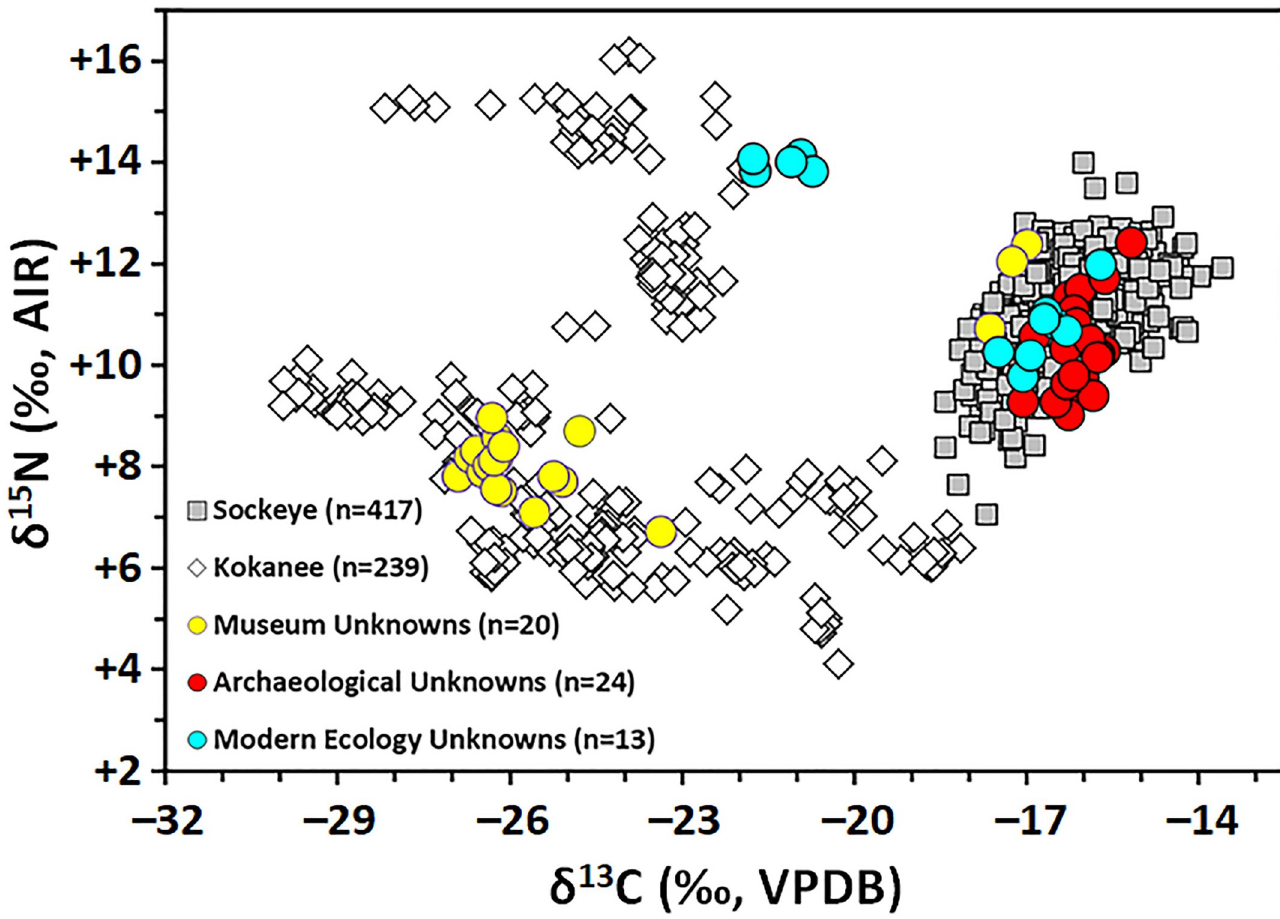
Fig 3. Stable carbon and nitrogen isotope compositions of O . nerka samples.